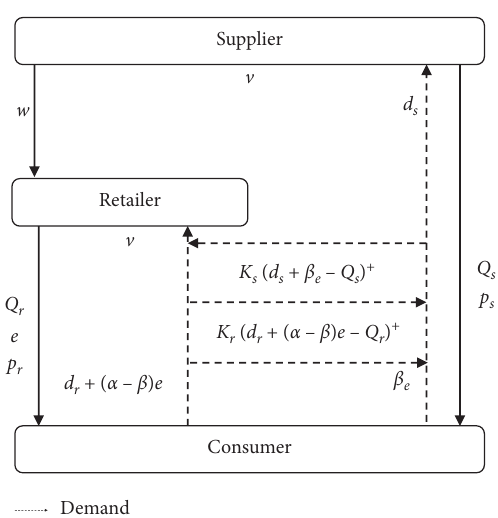
Figure 2: Dual-channel supply chain system.